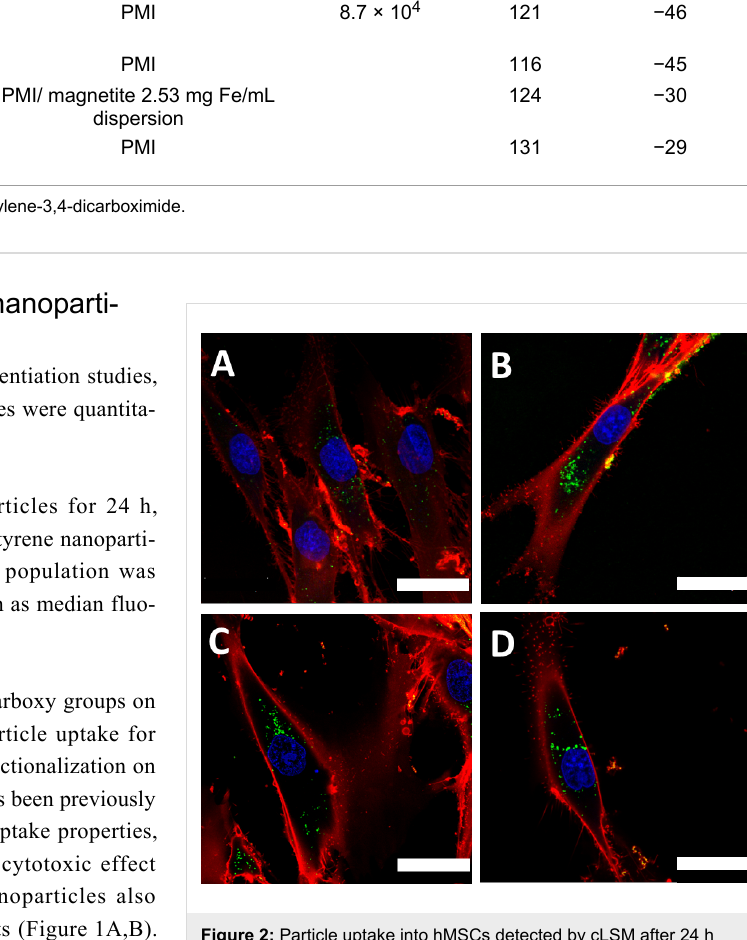
Figure 2: Particle uptake into hMSCs detected by cLSM after 24 h incubation with 300 µg/mL nanoparticles. (A) PS, (B) PS–COOH, (C) PLLA, (D) PLLA–Fe. The cell membrane is stained with CellMask Orange (red), nanoparticles are depicted in green, the cell nucleus is stained with DraQ5 and is pseudo-colored in blue. The white scale bar represents 25